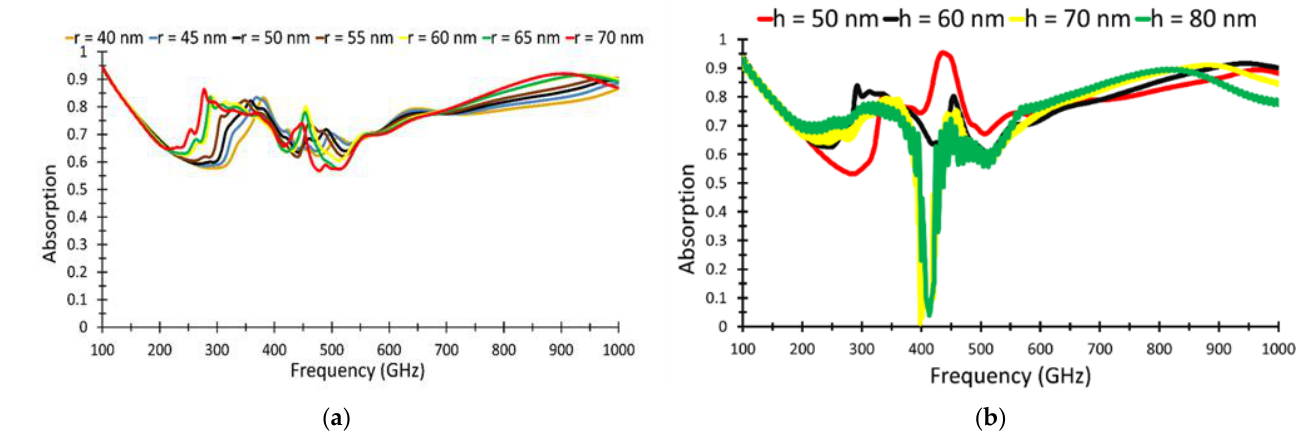
Figure 9. Absorption of the side-by-side multi-dielectric layers MMA structure with alternating nanorods with: ( a ) varying radius from 40 to 70 nm; ( b ) varying heights from 50 to 80 nm.